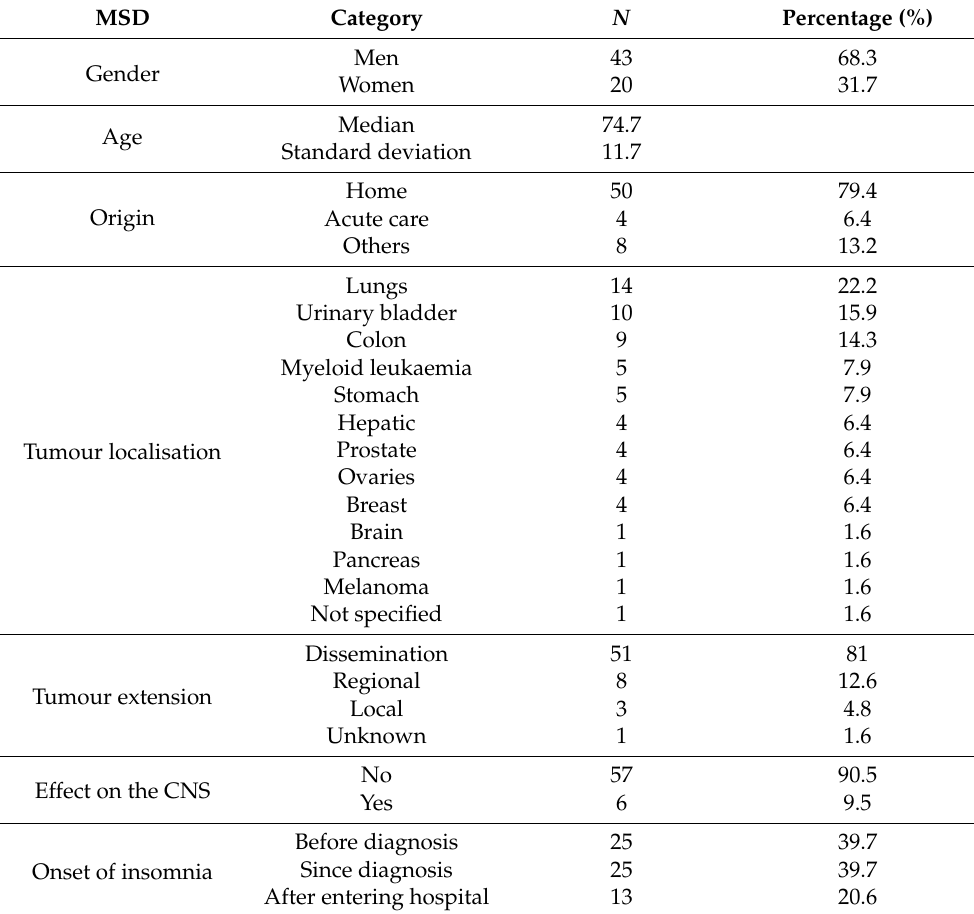
Table 1. Medical and sociodemographic data (MSD) of the patient ( N =